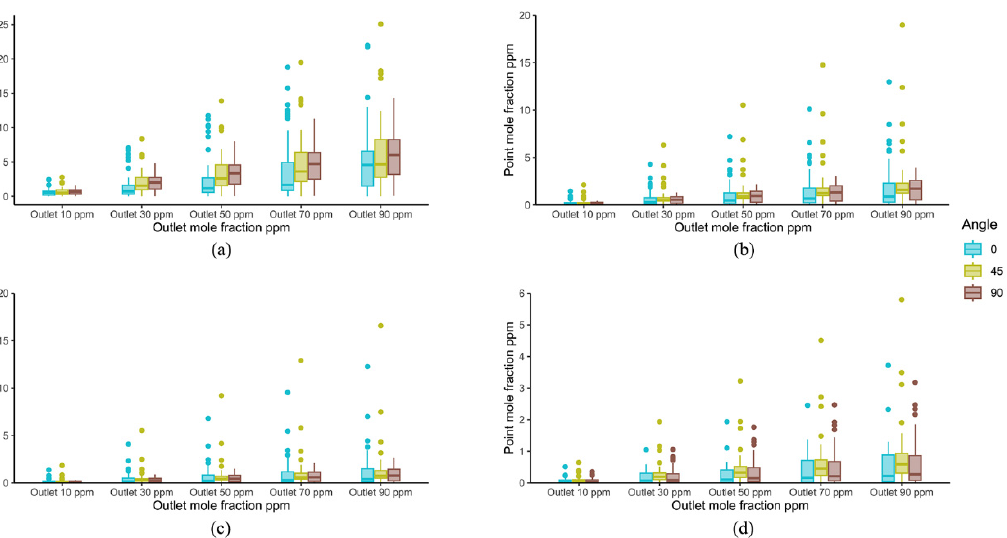
Figure 9. Box plot of ammonia mole fraction at random sampling points: scenarios with ( a ) 2 m; ( b ) 4 m; ( c ) 6 m; and ( d ) 8 m intervals between broiler chambers .